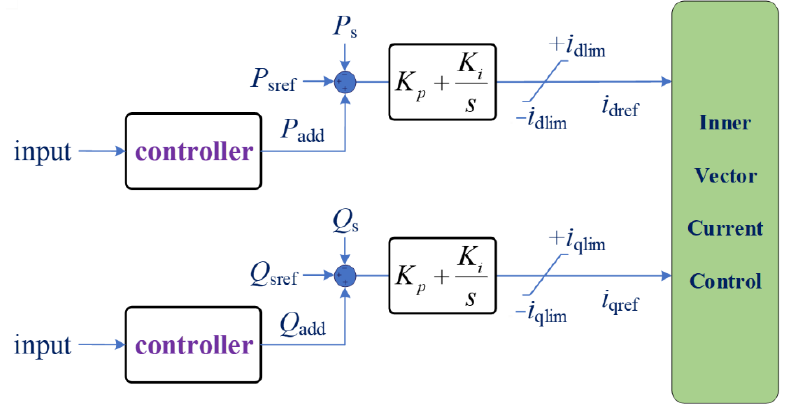
Figure 4. The control diagrams of Total Supplementary Damping control for IPFC.